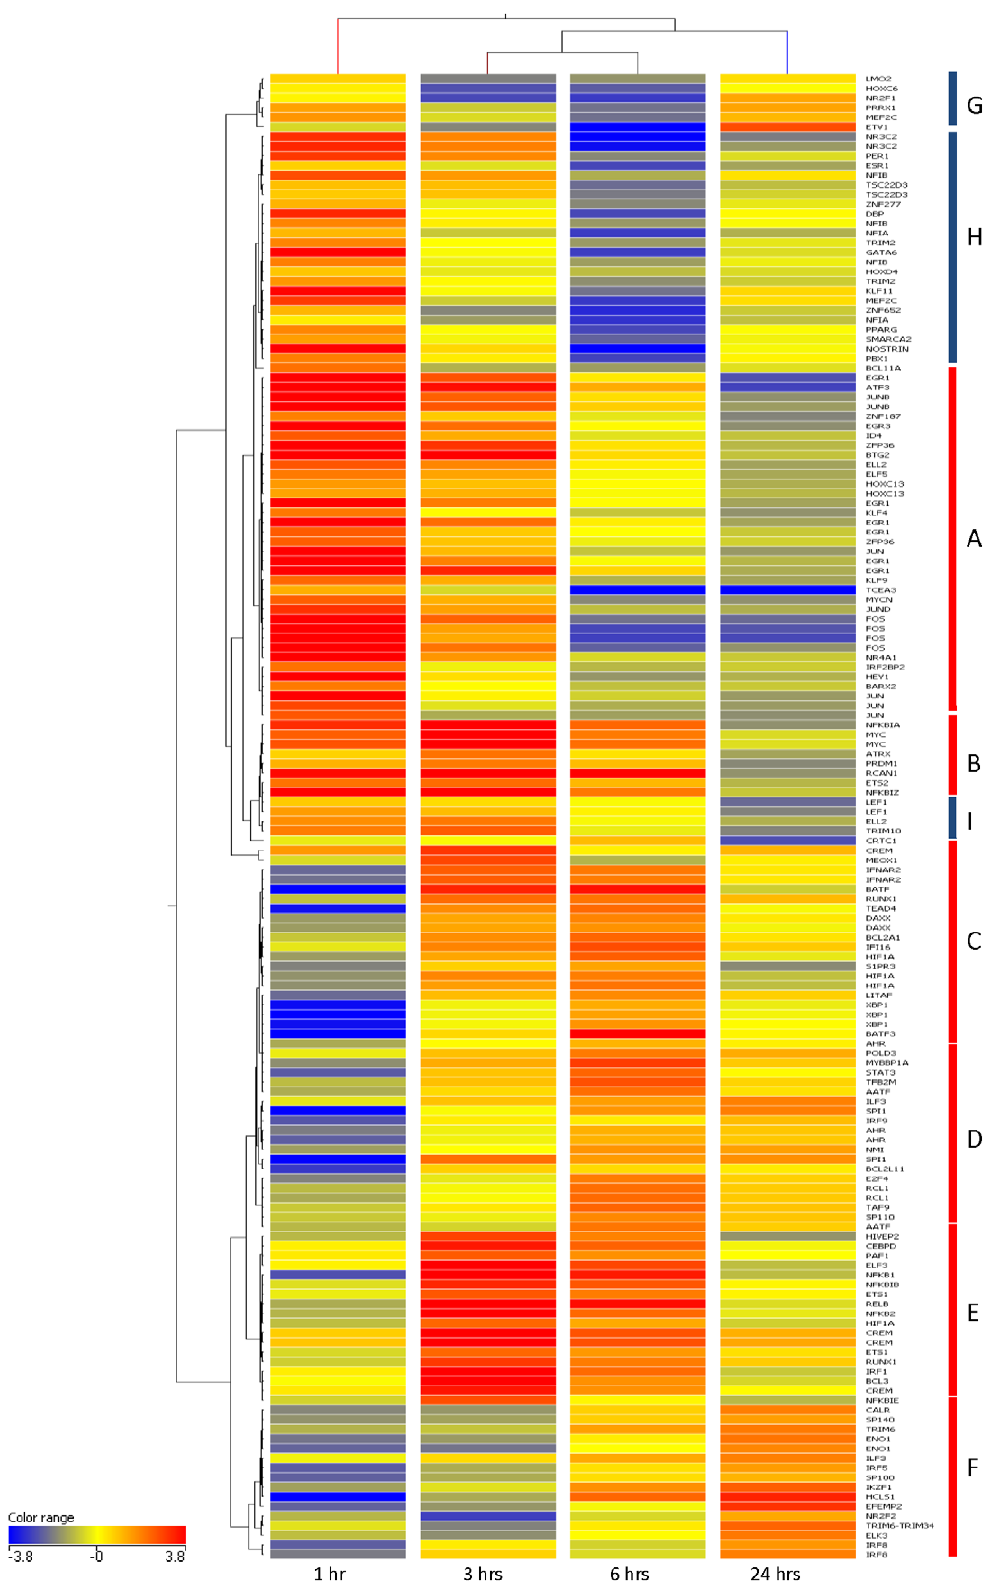
Figure 2. Hierarchical clustering analysis of transcription factor genes following infestation with P.ovis . Clustering preformed in Genespring GX 11.0 (Agilent, UK) using the Pearson Centered distance metric. Each block represents a single gene at each time point (Control (Time =0), 1 hour, 3 hours, 6 hours and 24 hours post-infestation). Genes are colour coded by log normalised intensity values. A-I = Clusters A –I (full description in text). doi:10.1371/journal.pone.0024402.g002 PLoS ONE |